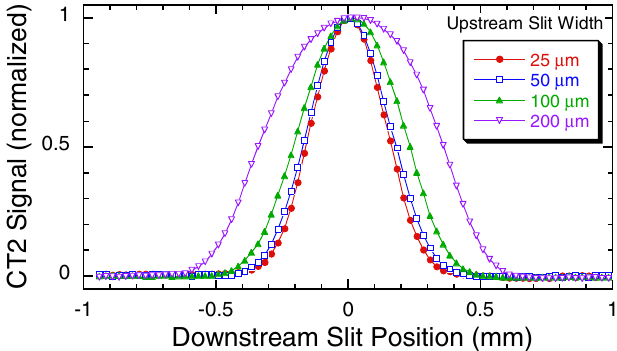
FIG. 10. (Color) Beamlet profiles for different upstream slit widths.